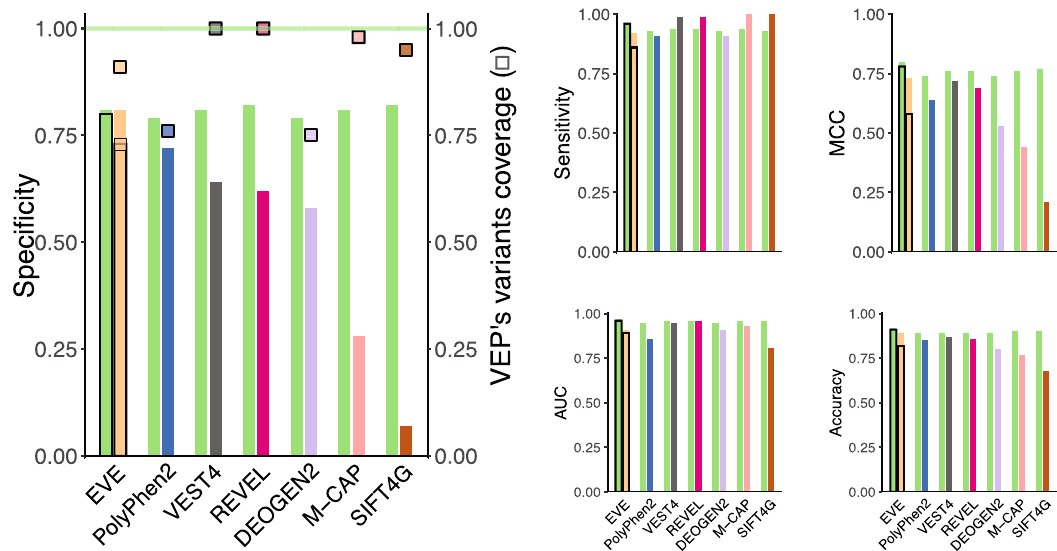
Fig. 5 | DeMAG outperforms other VEPs on clinical variants. Pairwise compar- ison of the performance of DeMAG and other VEPs on 1285 high-quality clinical variants from the ClinVar testing set (852 pathogenic and 433 benign variants), according to different performance metrics (speci fi city, sensitivity, Matthews Correlation Coef fi cient (MCC), ROC-AUC and accuracy). The left panel shows speci fi cityandvariantscoverageofVEPs(squares)(e.g.,SIFThas95%coverage,see Table1forexactvalues).Thegreenhorizontalline( y =1)indicatesthatDeMAGhas 100% coverage, ithasprediction forall variants. DeMAG ’ s high speci fi city isonpar